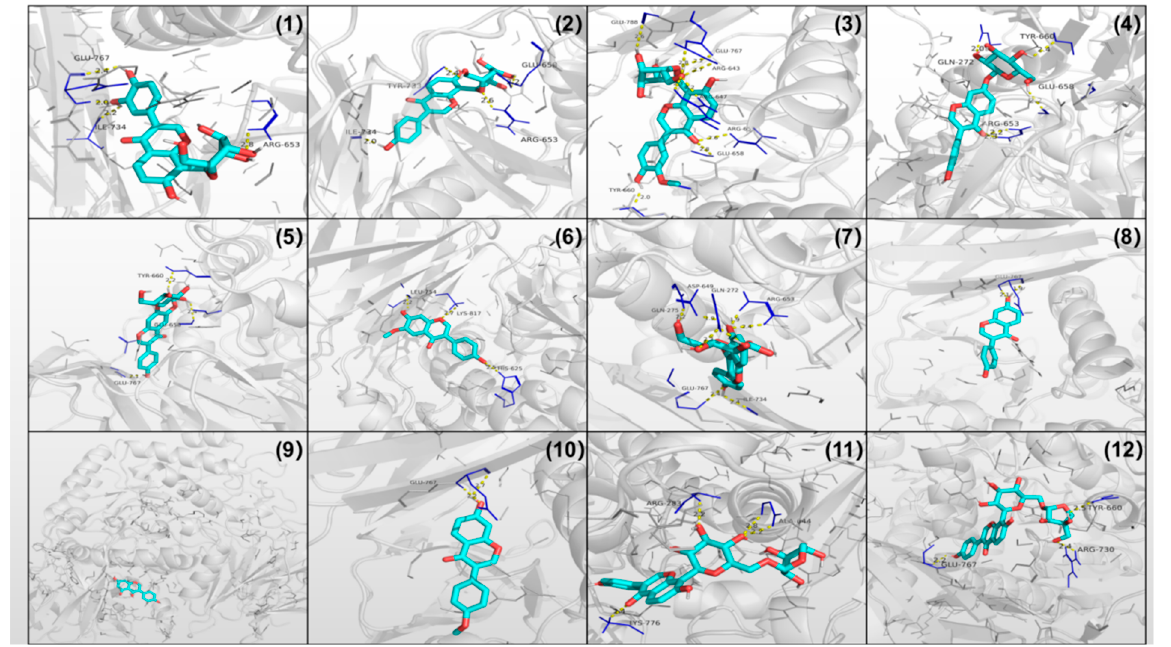
Figure 4. Molecular docking conformations of isoflavones with α -glucosidase (short, dotted yellow lines represent hydrogen bonds. ( 1 ). 3’-hydroxy puerarin, ( 2 ). puerarin, ( 3 ). 3’-methyoxy puerarin, ( 4 ). daidzin, ( 5 ). glycitin, ( 6 ). glycitein, ( 7 ). genistin, ( 8 ). daidzein, ( 9 ). genistein, ( 10 ).